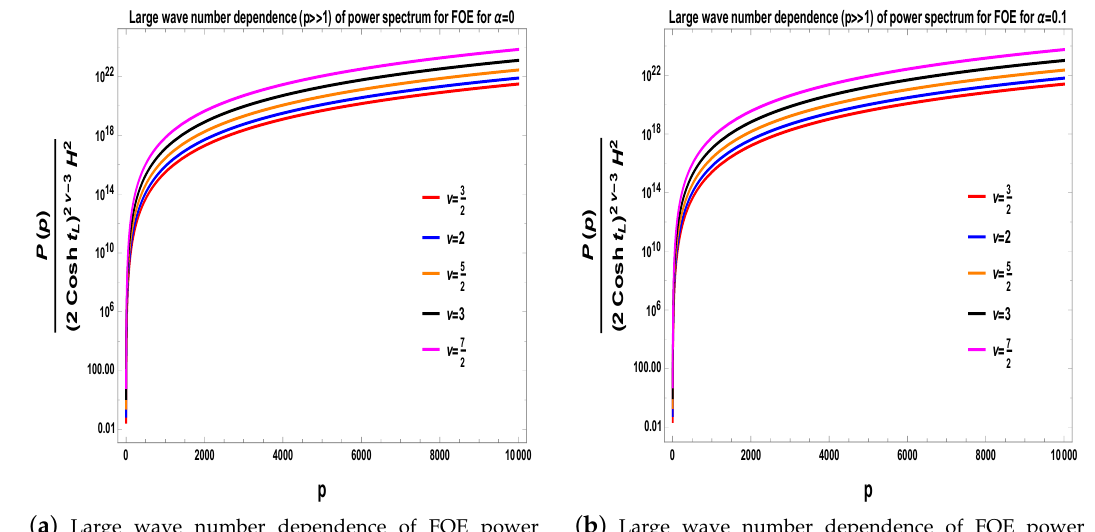
( a ) Large wave number dependence of FOE power ( b ) Large wave number dependence of FOE power spectrum for α = 0. spectrum for α = 0.1. Mass parameter dependence ( p >> 1 ) ofpowerspectrum for FOE for p = 7000